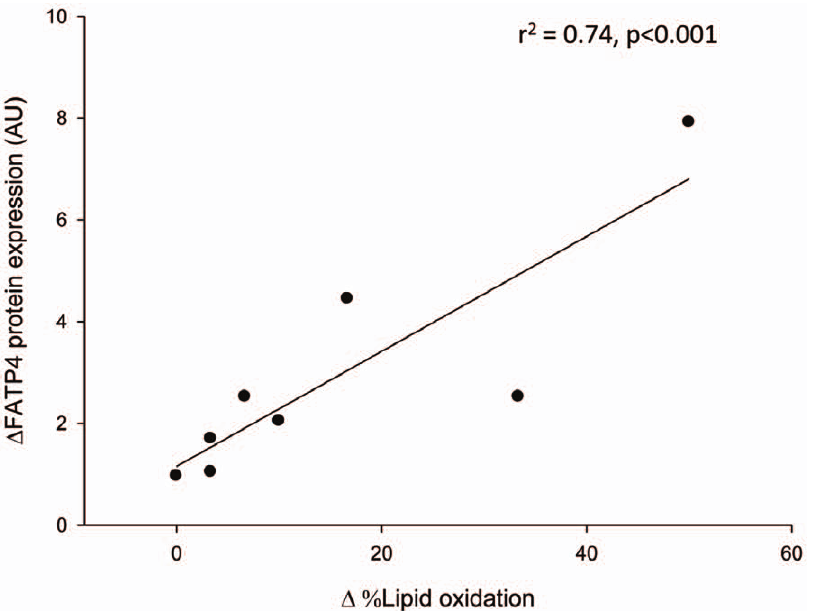
Figure 5. Association between lipid oxidation and exercise training induced adaptations in FATP4 protein expression in human skeletal muscle. Eight weeks of endurance exercise training resulted in a shift in substrate choice towards a higher FA utilization during submaximal exercise. This training induced adaptation was associated with the observed increase in FATP4 protein expression.